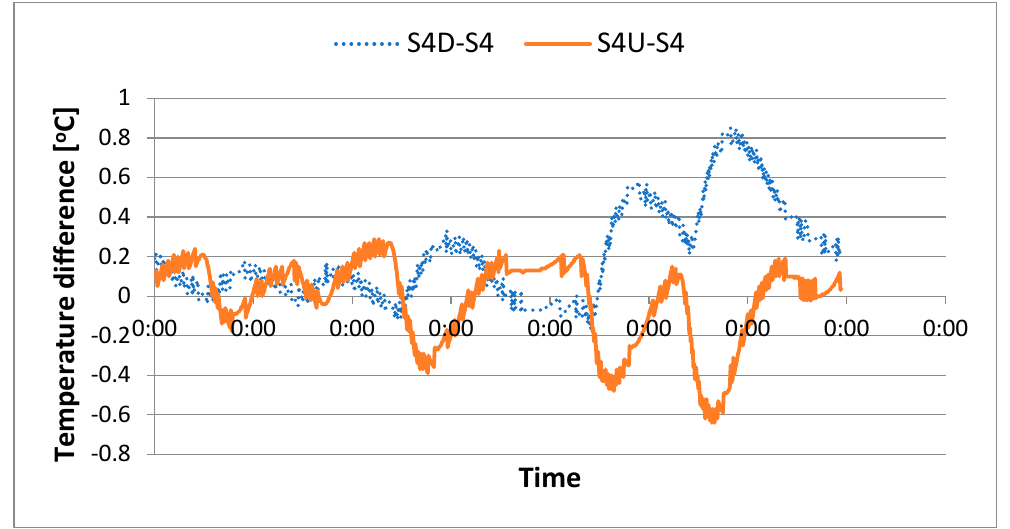
Figure 7. Temperature differences S4D-S4 and S4U-S4 indicating vertical heat flow in wall on 23–30 January 2020.